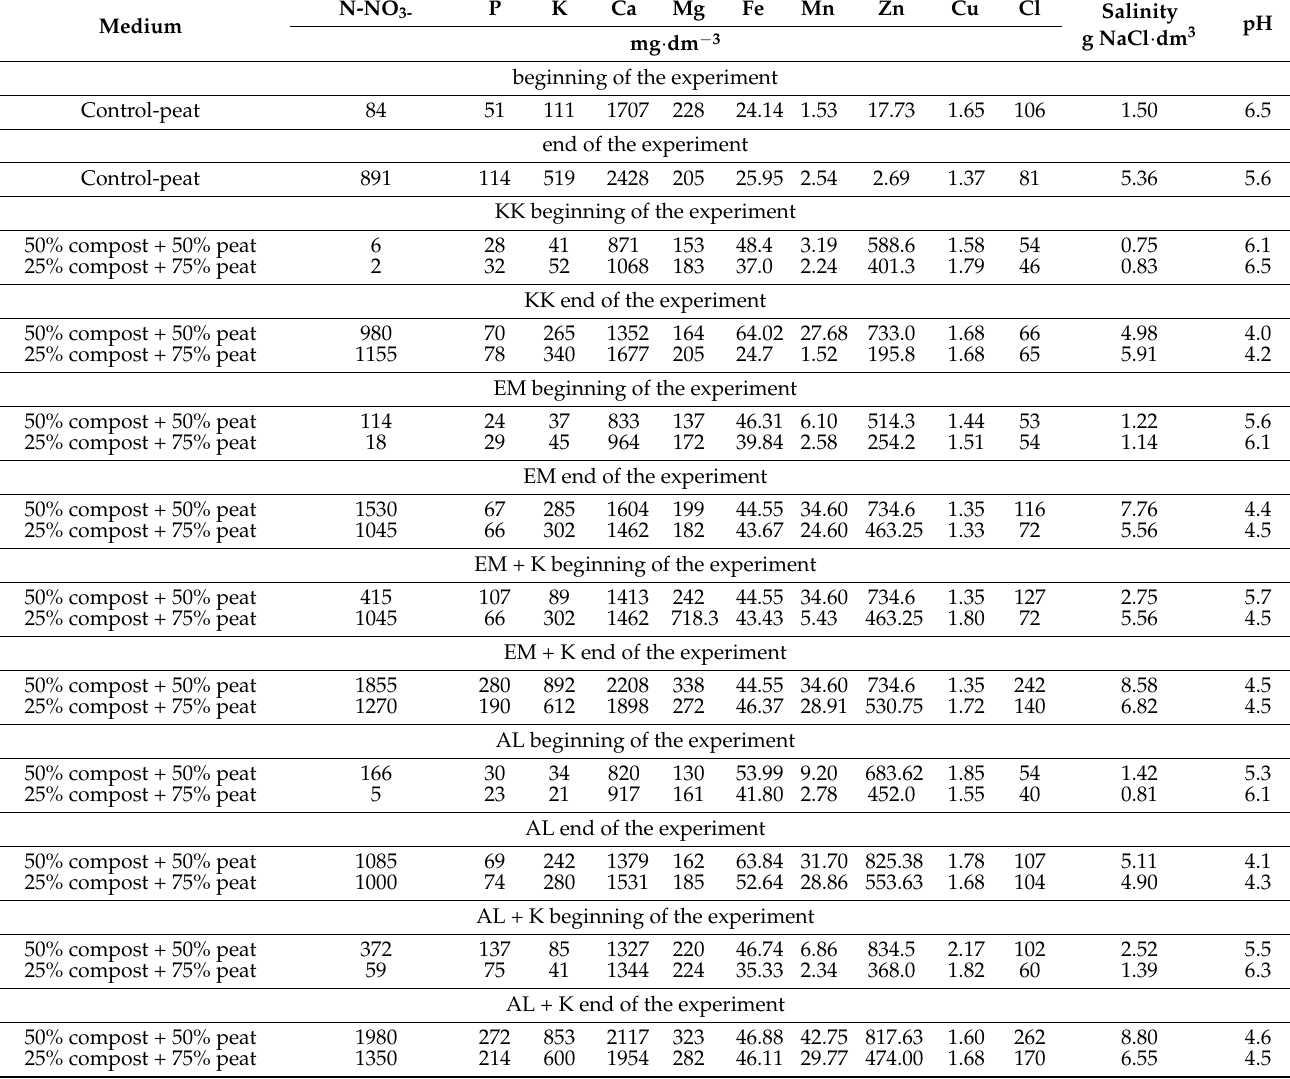
Table 5. The chemical composition of the medium used at the beginning and after the end of the